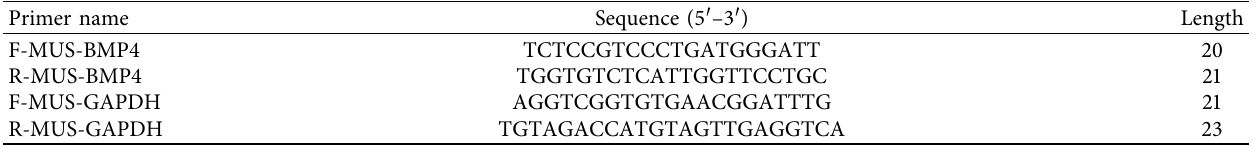
Table 1: Primer sequence of real-time